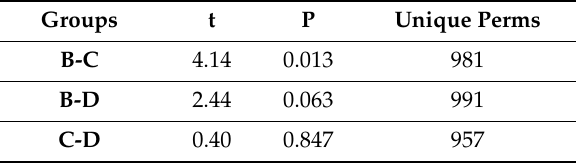
Table 5. Pair-wise comparisons between sampling stations.